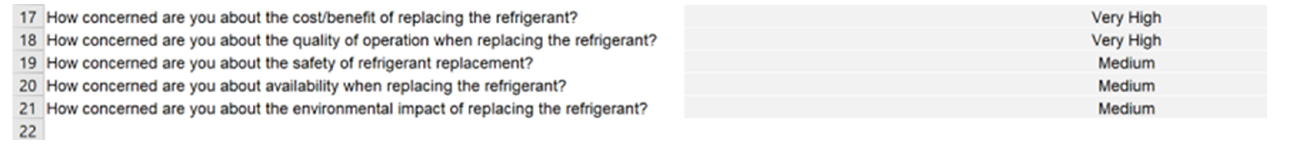
Figure 6. Filling in the parameters of the restrictions in the case of R-422.